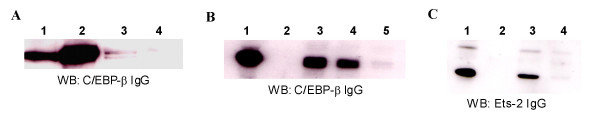
C/EBP-β and Ets-2 interaction demonstrated by A) co-immunoprecipitation, B) and C) pull-down assays with biotinylated C/EBP oligonucleotide (-117 to -109) in JEG-3 cell extracts (CE). A) Lane 1: JEG-3 CE (positive control for western blot); lane 2: immunoprecipitation (IP) with C/EBP-β IgG (positive control for IP); lane 3: IP with Ets-2 IgG; lane 4: IP with non-immune rabbit IgG (negative control for IP). Western blot (WB) was performed with C/EBP-β IgG. B) WB performed with C/EBP-β IgG as detection reagent following pull-down assays. Lane 1: JEG-3 CE (positive control for WB); lane 2: biotinylated C/EBP oligonucleotide; lane 3: JEG-3 CE+biotinylated C/EBP oligonucleotide; lane 4: JEG-3 CE+biotinylated C/EBP oligonucleotide+250-fold molar excess unlabeled mutated C/EBP oligonucleotide; lane 5: JEG-3 CE+biotinylated C/EBP oligonucleotide+250-fold molar excess unlabeled wild type C/EBP oligonucleotide. C) WB with Ets-2 IgG as the detection agent following pull-down assays. Lane 1: JEG-3 CE (positive control for WB); lane 2: biotinylated C/EBP oligonucleotide; lane 3: JEG-3 CE+biotinylated C/EBP oligonucleotide; lane 4: JEG-3 CE+biotinylated C/EBP oligonucleotide+250-fold molar excess unlabeled wild type C/EBP oligonucleotide.